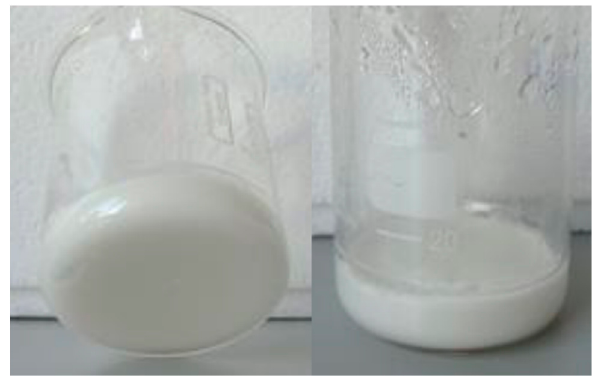
Figure 6. YogAur produced with SAuNPs–ferment obtained after 2 h of incubation.